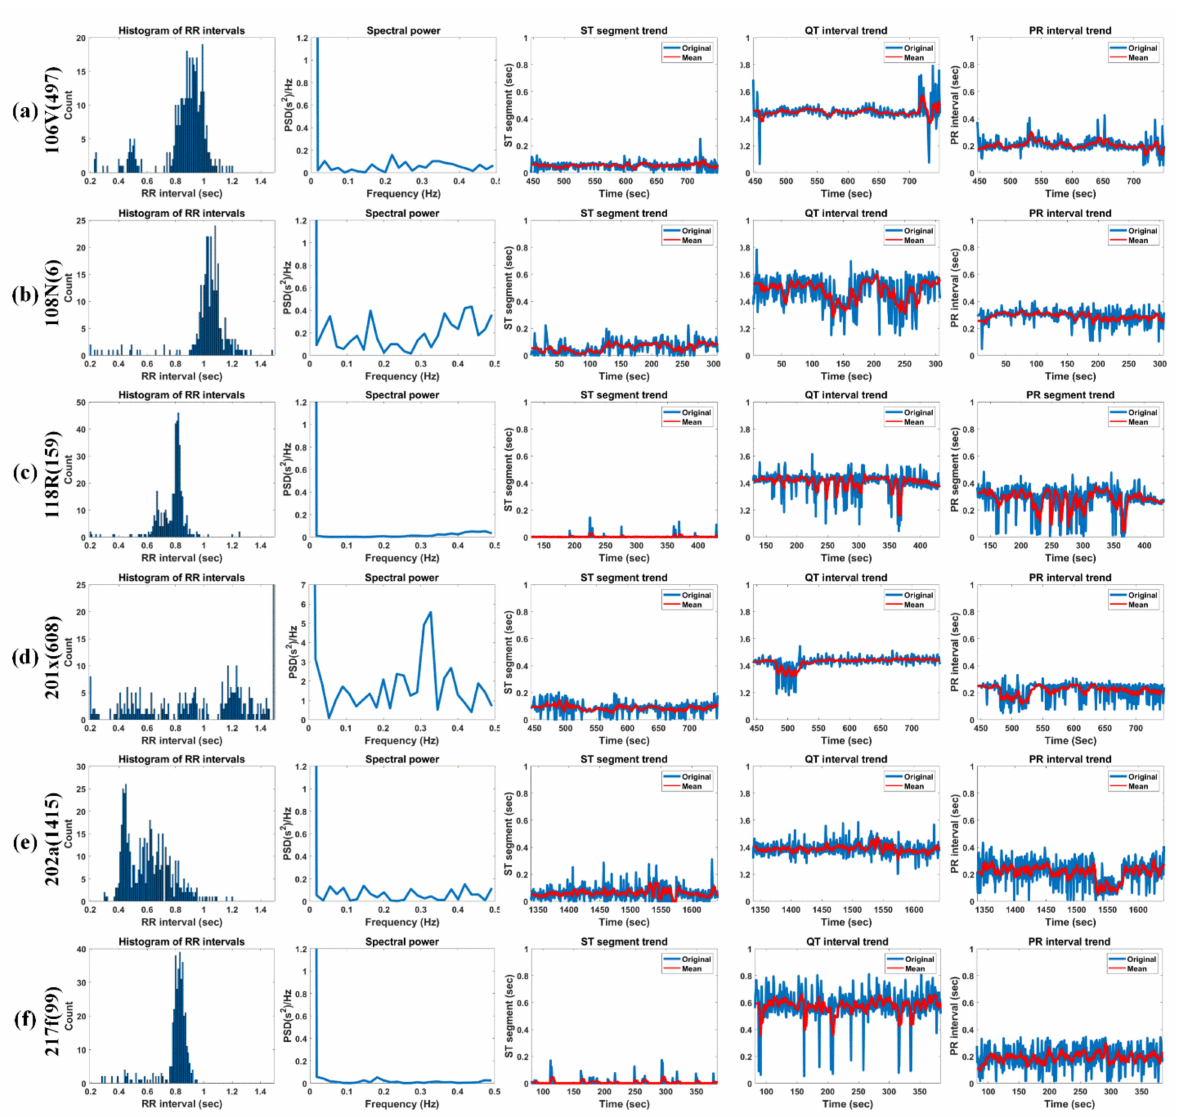
Figure 15. HR trend, RRI trend, histogram of RRIs, spectral power, ST-segment, QT-interval, and PR-interval for 5 min length of Record ( a ) 106V(497), ( b ) 108N(6), ( c ) 118R(159), ( d ) 201x(608), ( e ) 202a(1415), and ( f ) 217f(99) in